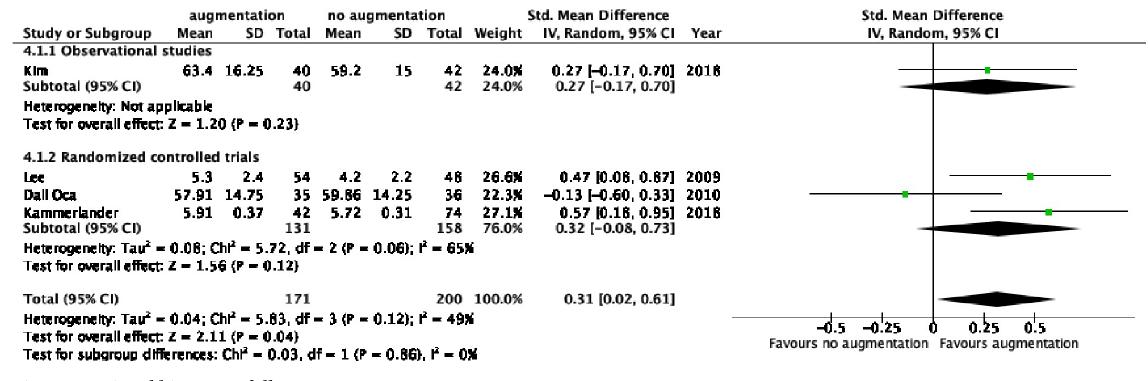
Fig 4. Functional hip scores follow up.